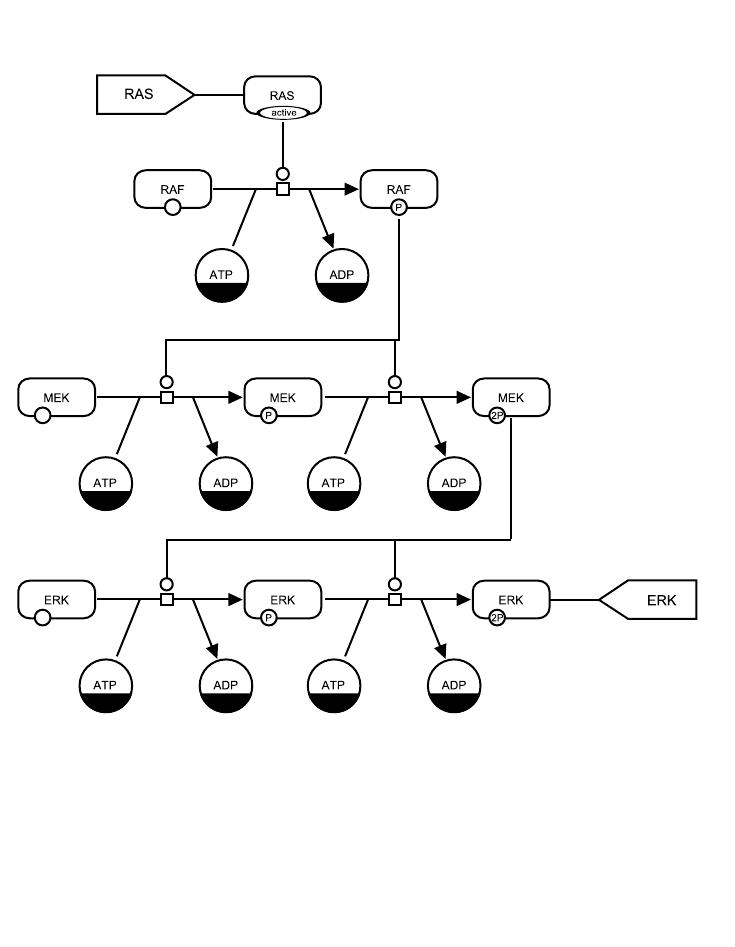
Figure A.3: A submap of the previous map showing the MAPK